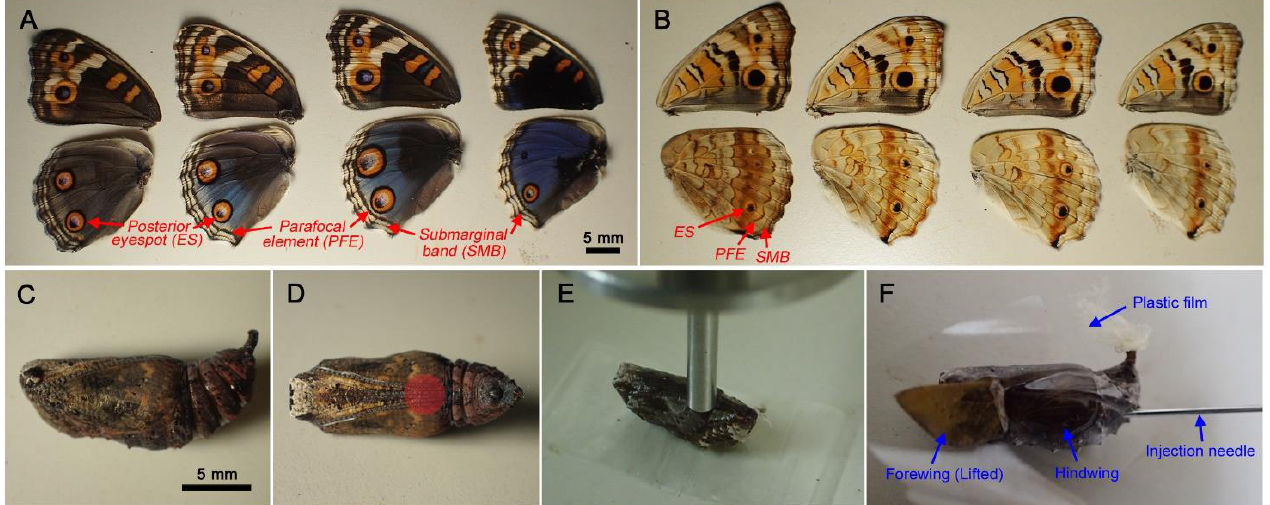
Figure 1. Wing color patterns and experimental procedures. ( A ) Dorsal wings of three females (left) and one male. The posterior eyespot (ES), distal parafocal element (PFE), and submarginal band (SMB) are indicated. ( B ) Ventral hindwings of individuals shown in A. ES, PFE, and SMB are indicated. ( C ) Side view of a pupa. This pupa is immediately before eclosion. Forewing color patterns are seen through the pupal cuticle. ( D ) Ventral view of a pupa. The position of a gauge probe is shown by a red circle. ( E ) A pupa with a gauge probe for the mechanical load test. ( F ) A pupa with a forewing lift configuration with an injection needle. Lifted wing surfaces are covered with a piece of transparent plastic film.